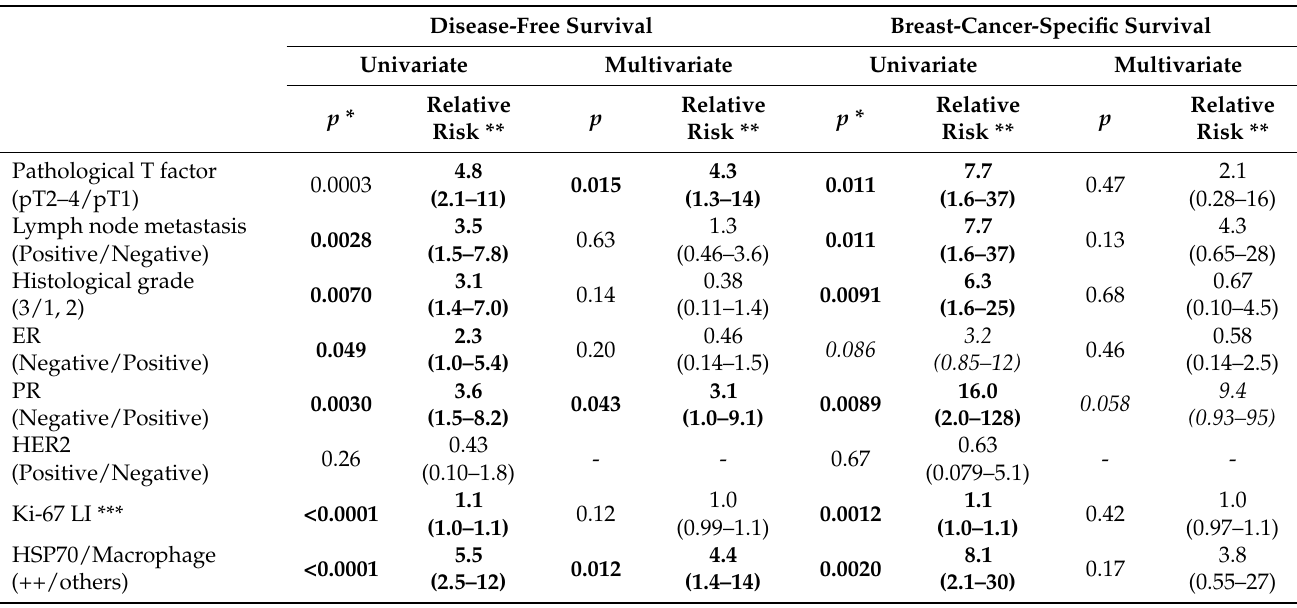
Table 2. Summary of univariate and multivariate analyses of clinical outcomes in 116 breast carci- noma patients.